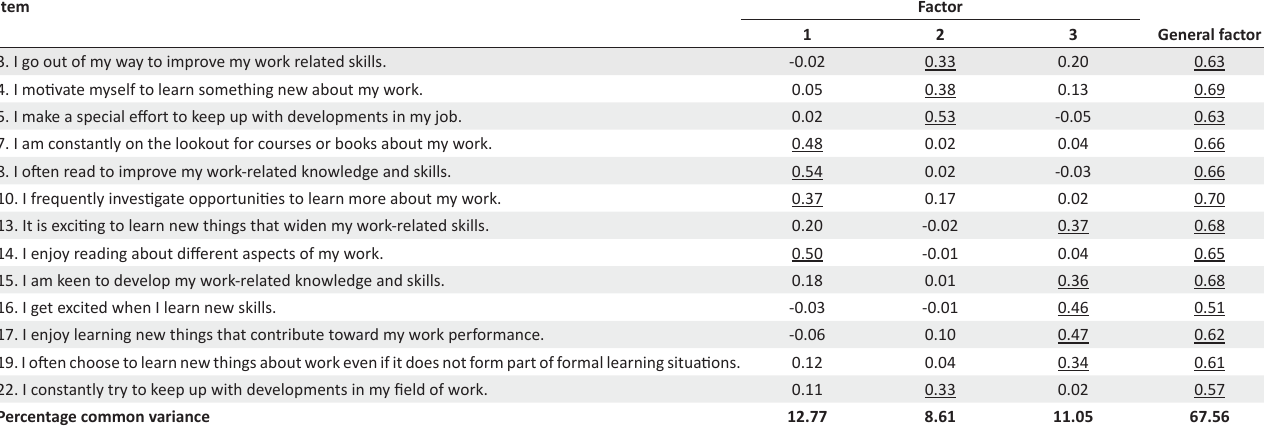
TABLE 5: Schmid-Leiman hierarchical factor solution for the learner self-directedness items.